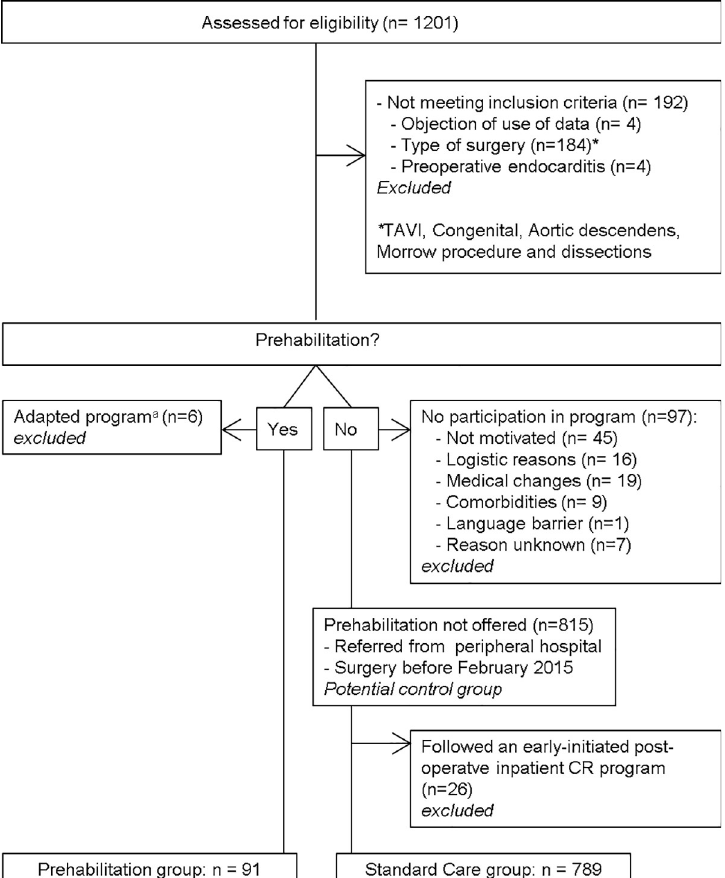
Fig 2. Flow chart of the recruitment. a Patients who were not able to cycle on an ergometer and followed other exercise modalities.